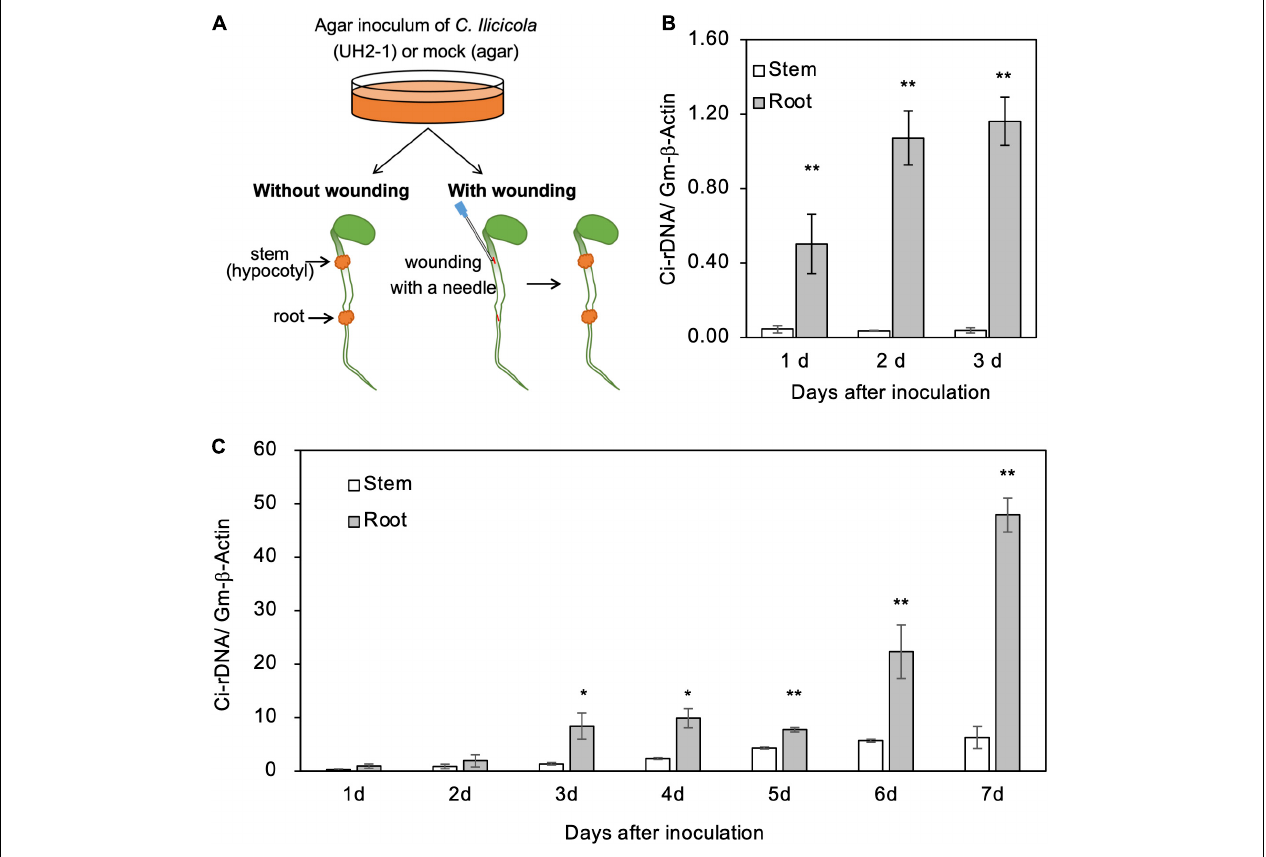
FIGURE 4 | Relative fungal growth in roots and stems of soybean seedlings. (A) Illustration of method for direct inoculation of Calonectria ilicicola to the roots and stems. Agar inoculum was applied to a 5-mm diameter spot on the radical roots and stems (hypocotyl) of 4-day-old seedlings with or without wounding. (B,C) Relative fungal growth (Ci-rDNA/Gm- β -Actin) in non-wounded (B) and wounded (C) roots and stems. Asterisks indicate significant differences (non-parametric t -test, *, p < 0.05; **, p <